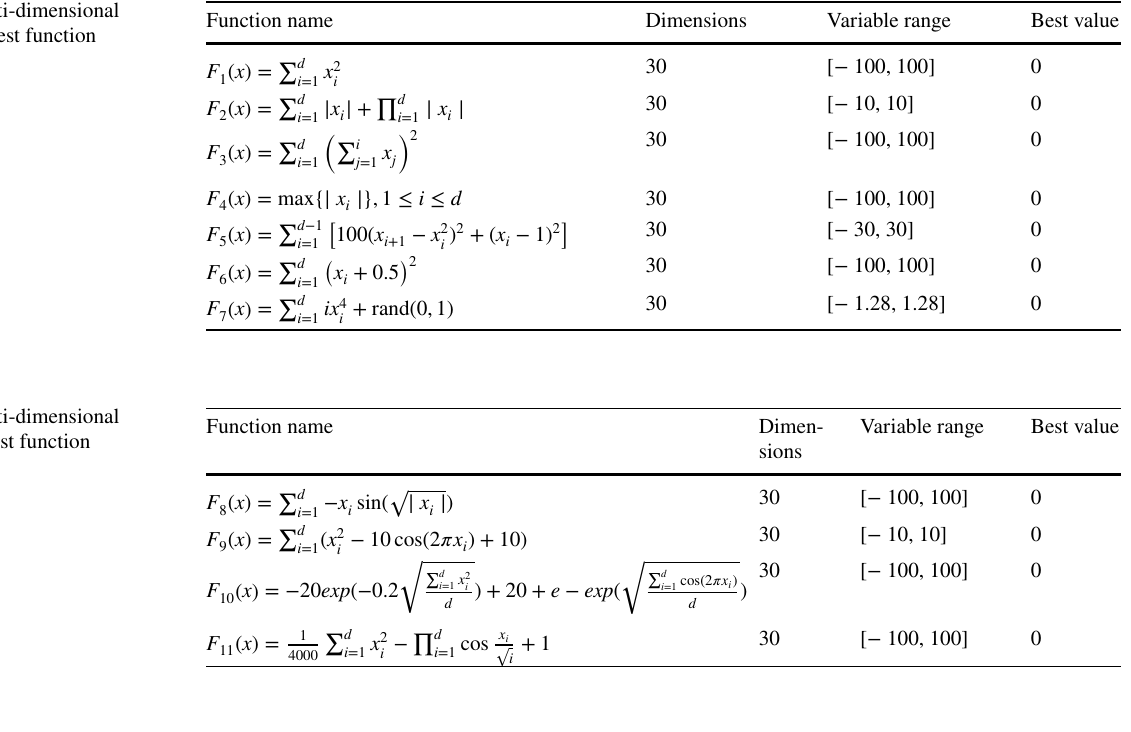
Table 3 Experimental results on multidimensional unimodal functions based on different